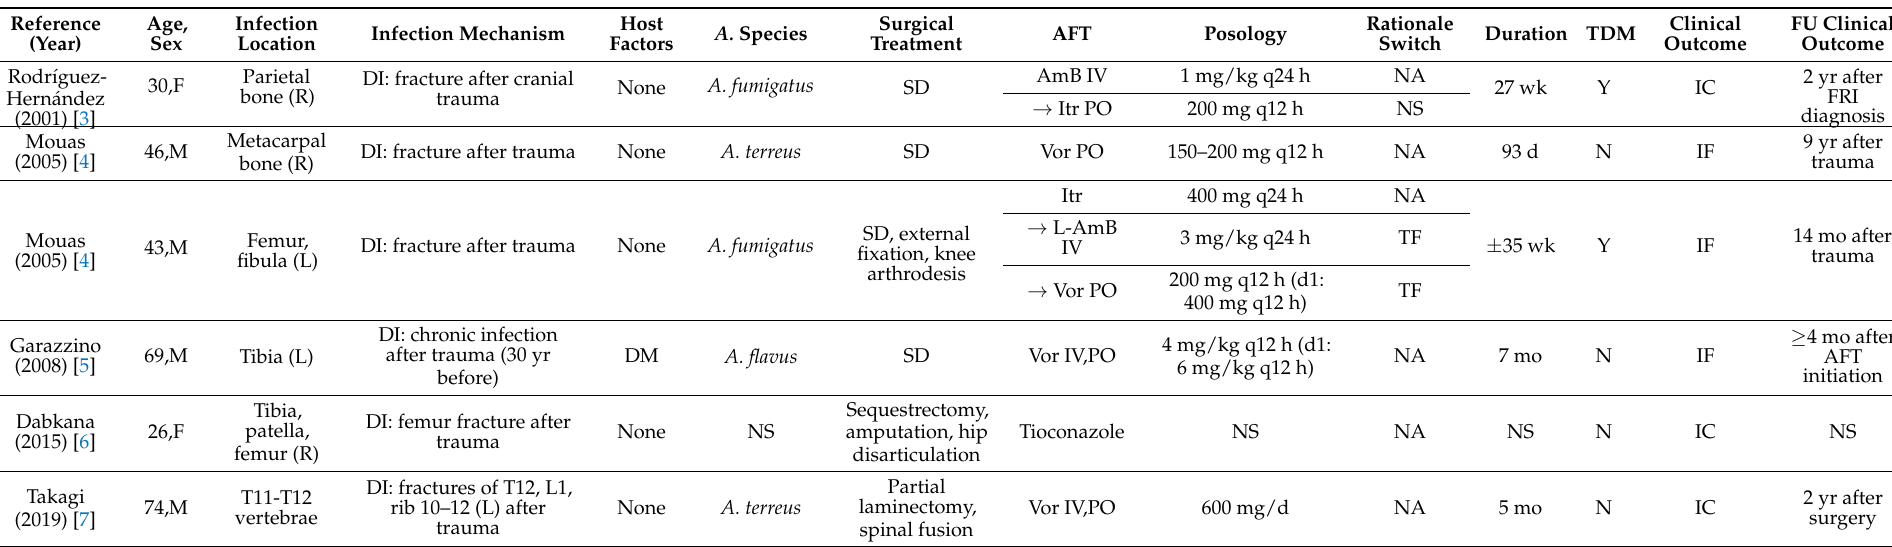
Table 1. Demographic, clinical and therapeutic characteristics of Aspergillus fracture-related infections ( n =